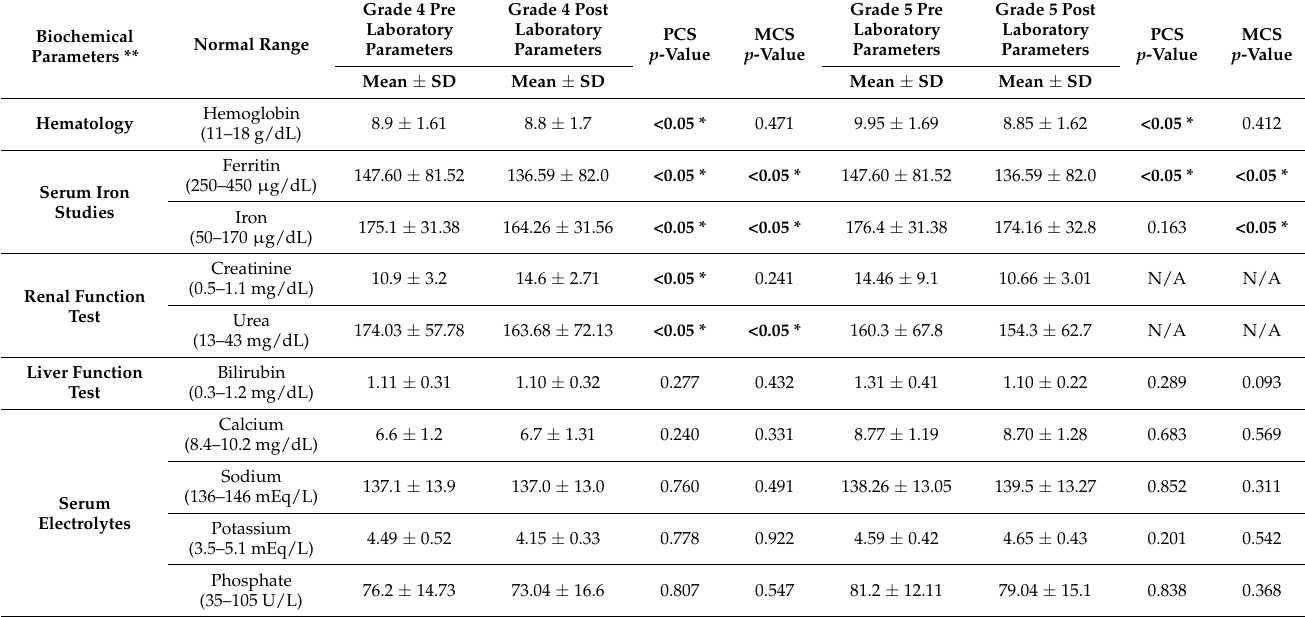
Table 2. Multivariate analysis of laboratory parameters and their correlation with Quality of Life.